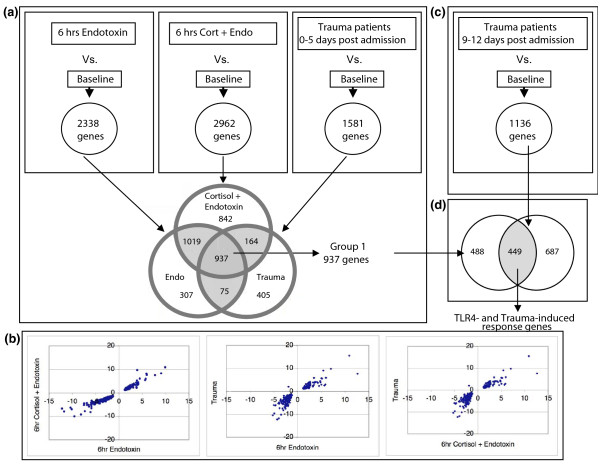
TLR4 and injury responsive (TIR) genes selection criteria. (a) Genes that were significantly differentially expressed (P- value < 0.05 and ≥1.2-fold change) in PBL obtained from subjects challenged with in vivo endotoxin (Endo) for six hours (2 ng/kg), subjects infused with cortisol (Cort) (3 μg/kg/min) for 12 hours starting 6 hours before endotoxin administration (Cort + Endo), or from trauma patients PBL obtained within the initial five days after ICU admission, as compared to baseline, were identified. The Venn diagram identifies the genes that are common between groups. Nine hundred thirty-seven (937) genes were common to all three groups. (b) Scatter plot analysis comparing Group 1 genes expression trends between the indicated groups. (c) Genes that were significantly differentially expressed in trauma patients PBL obtained within 9 to 12 days after ICU admission as compared to baseline were identified. (d) Four hundred and forty-five genes were differentially expressed in both in vivo endotoxin challenged PBL and in PBL obtained from trauma patients over a period of 1 to 12 days after admission.